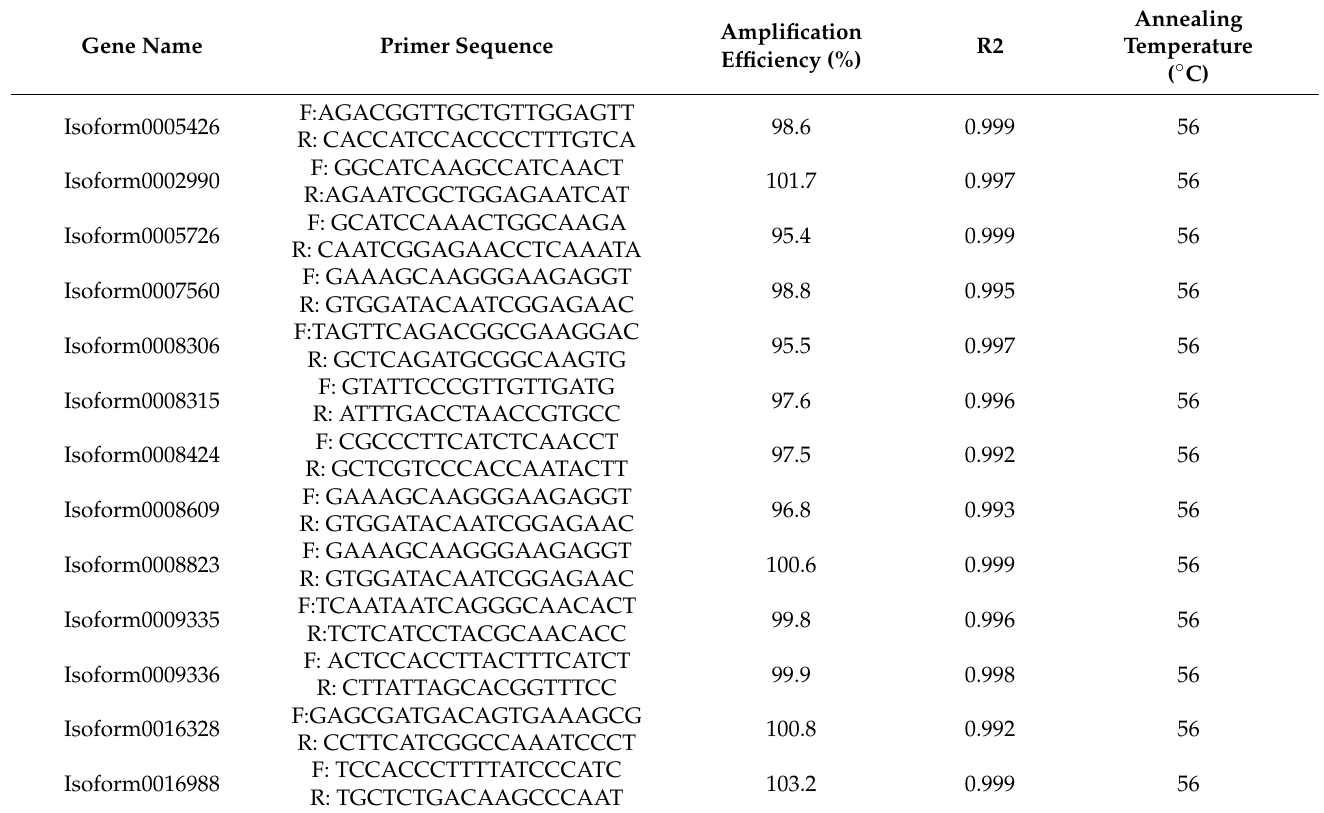
Table 4. Genes for RT-qPCR and their primer